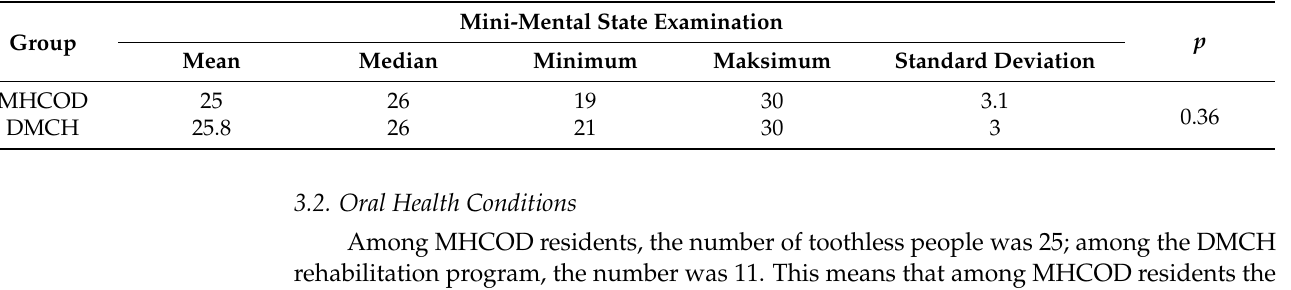
Table 2. Mini-Mental State Examination